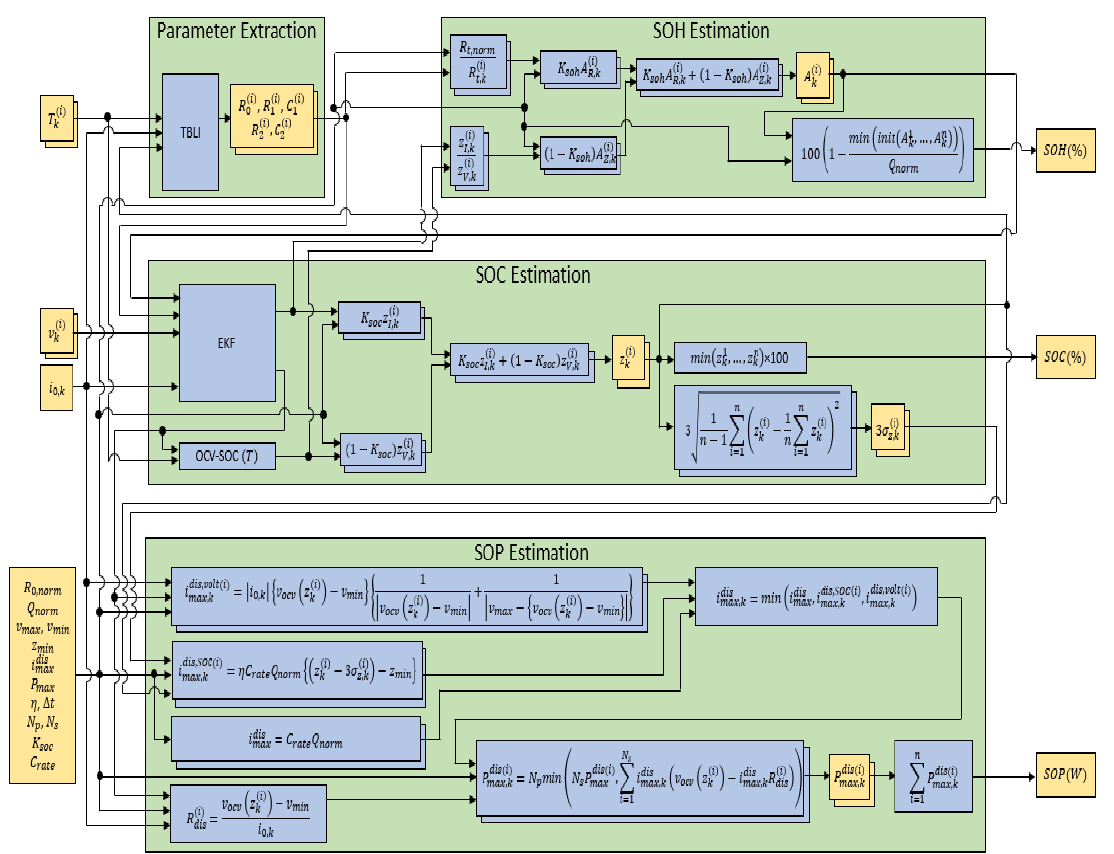
Figure 9. Flowchart of battery state estimation.